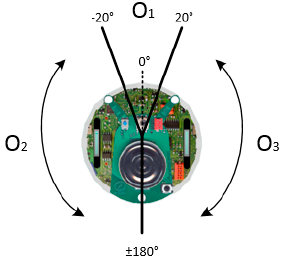
Figure 24. Divided zones of the mobile robot.